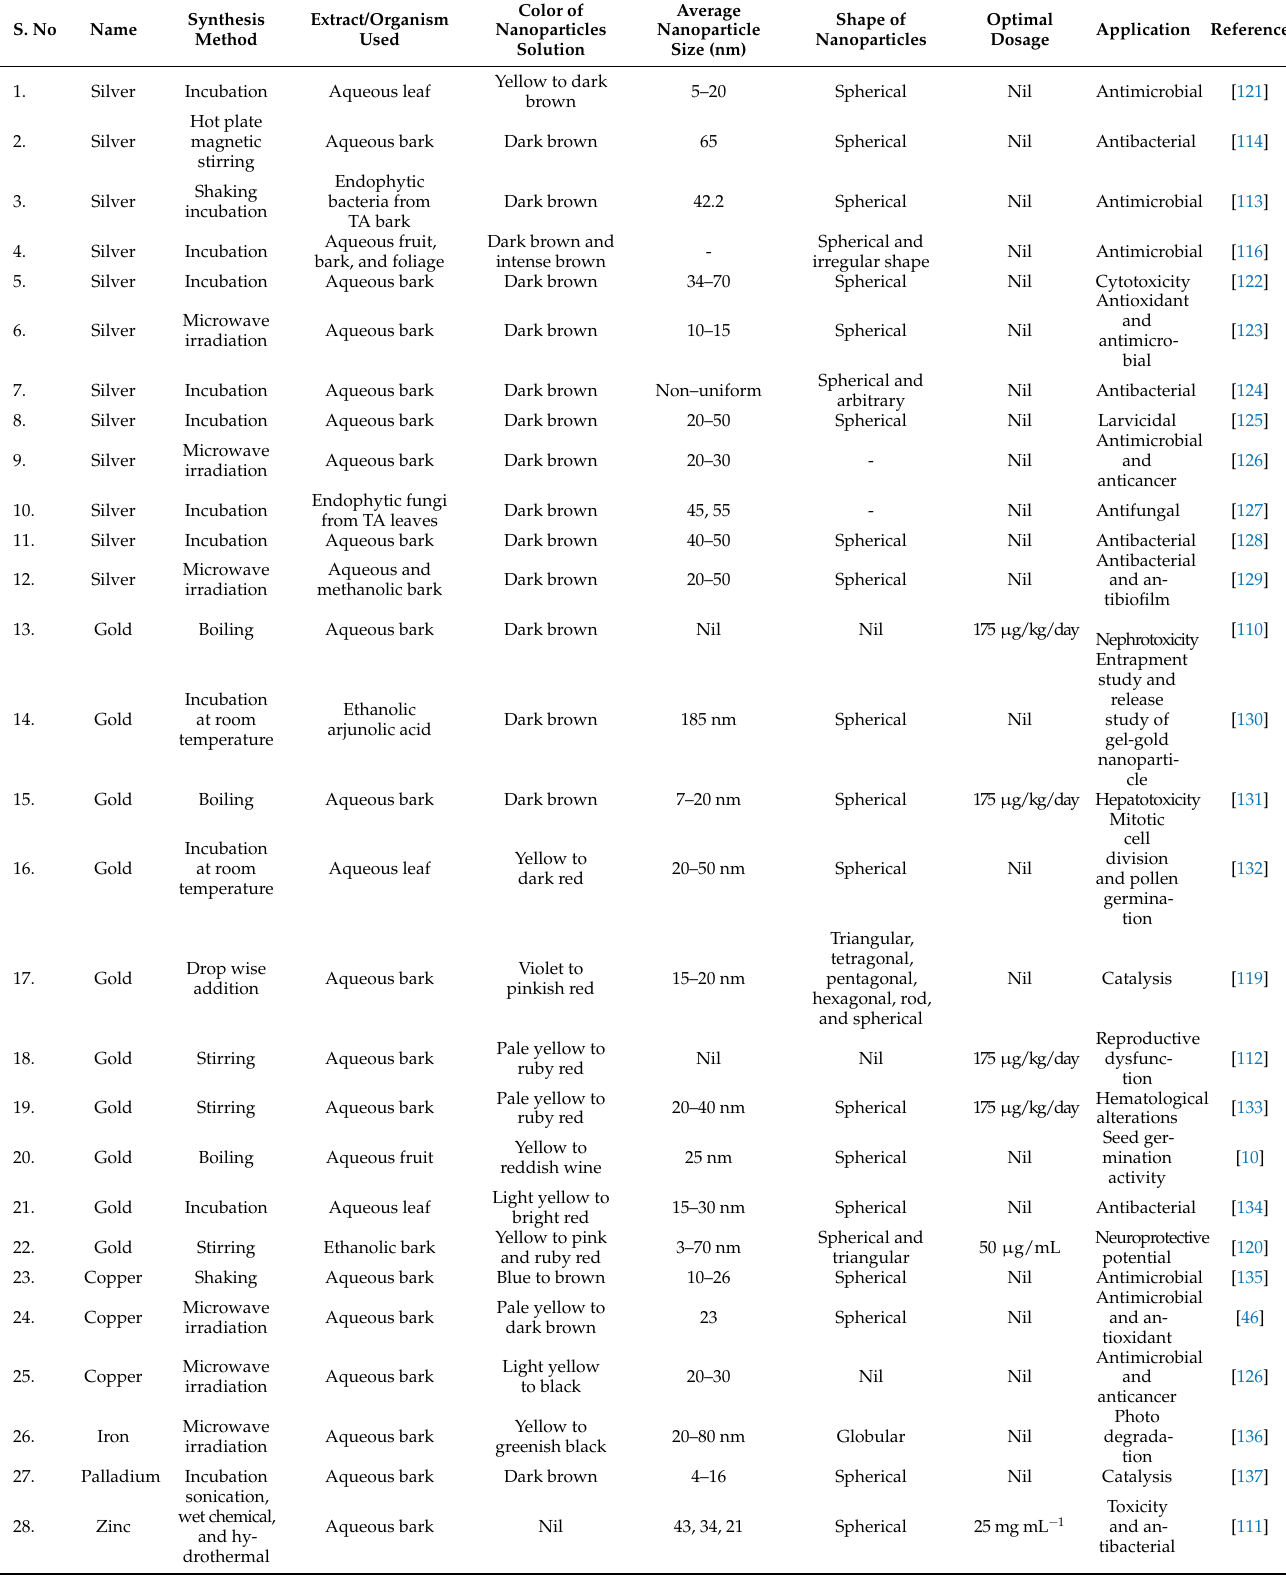
Table 2. Summary of green synthesized nanoparticles using TA extracts for various biomedical